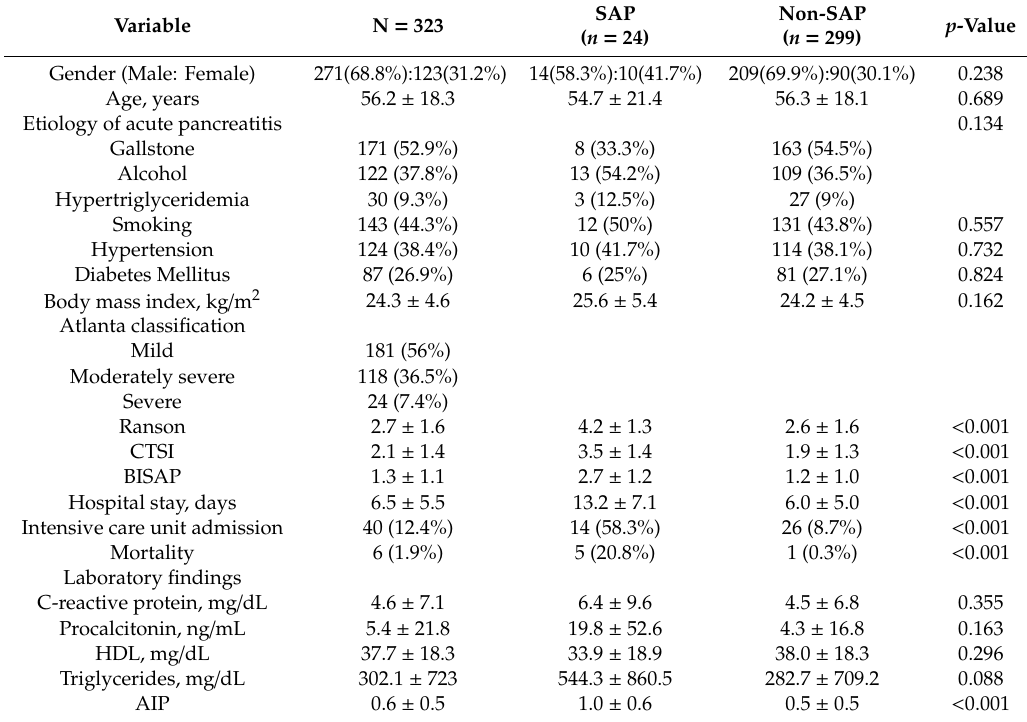
Table 1. Baseline characteristics of all the patients.